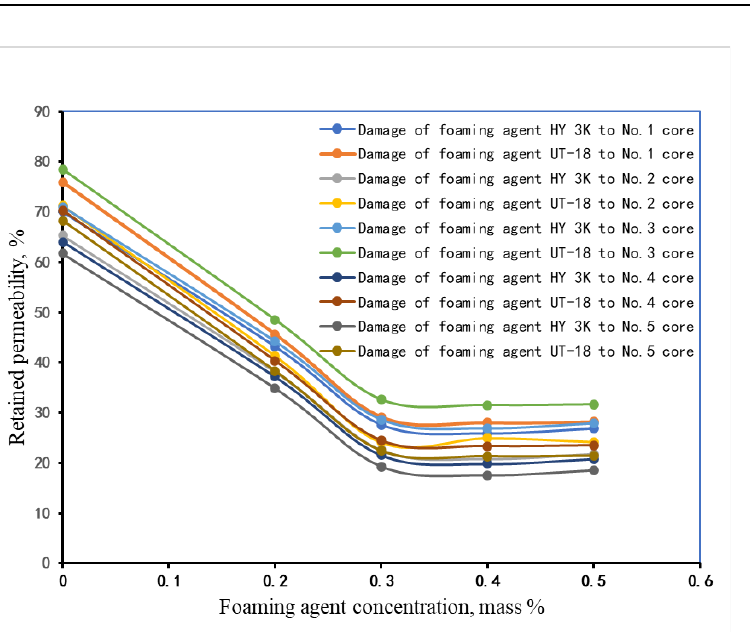
Figure 3. Permeability damage rate curves of five cores with different foaming agent concentrations. Foaming agent HY-3K reduced the capillary pressure by decreasing the interfacial tension and modifying the contact angle, as shown in Figure 4. The contact angles were measured as 88.4 degrees after treatment from surfactants in comparison to 38.3 degrees without treatment.